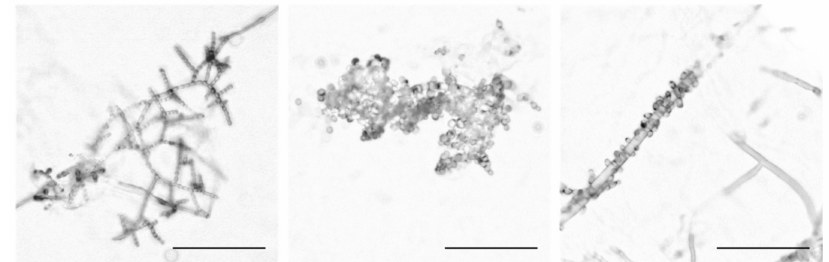
Figure 1. The three conidiophore architectural phenotypes. The Wild-Type (WT) phenotype is depicted in the first panel with FGSC2489, followed by the Bulky phenotype with FGSC8878, and Wrap with FGSC8876. Scale bar, 100 microns ( µ